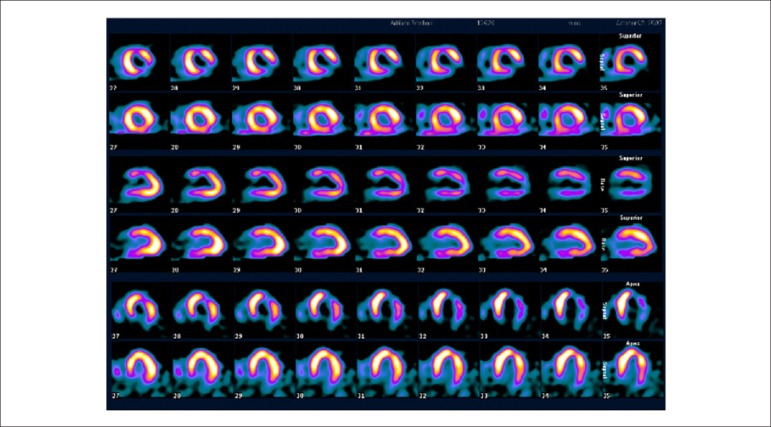
Case 2 - Myocardial perfusion scintigraphy showing important myocardial perfusion abnormalities, with multivessel ischemia and transient left ventricular cavity dilatation, representing high-risk indicators. Images acquired with dedicated cardiac equipment (gamma camera), equipped with conventional sodium iodide crystals.